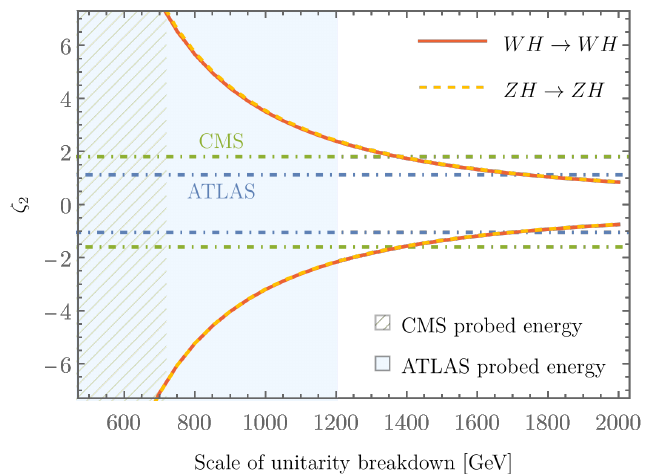
Figure 1 . Perturbative unitarity bounds on κ 2 V = 1 + ζ 2 at different scales from the V H → V H channels. The expected 95 % C.L. constraints from ATLAS [37] κ 2 V ∈ [ − 0 . 05 , 2 . 12] , and from CMS [38] κ 2 V ∈ [ − 0 . 6 , 2 . 8] are also overlaid. The ATLAS results are obtained from the HH → b ¯ bb ¯ b final state probing energies in the shaded region m HH ≤ 1200 GeV, while CMS probed up to m HH ∼ 720 GeV with the b ¯ bτ ¯ τ final